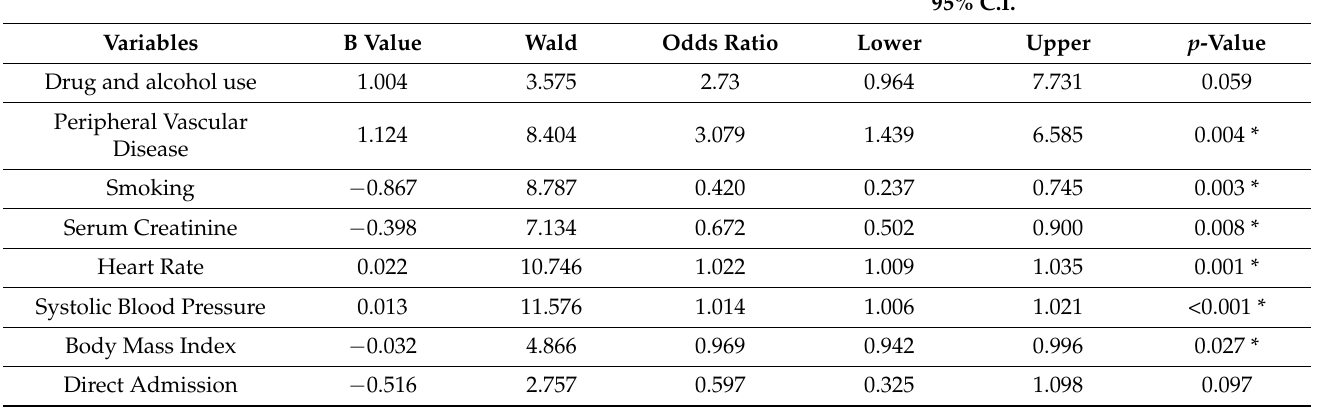
Table 2. Factors associated with stroke severity in the AIS population of Patients with Heart Failure between 65–74 and ≥ 75 years old. Adjusted OR < 1 denotes factors that are associated with AIS-HF patients in the 65–74 years old category, while OR > 1 denotes factors that are associated with AIS-HF patients ≥ 75 years old. Hosmer-Lemeshow test ( p = 252), Cox & Snell (R 2 = 0.112). The overall classified percentage of 63.0% was applied to check for the fitness of the logistic regression model. * Indicates statistical significance ( p < 0.05) with a 95% confidence interval.